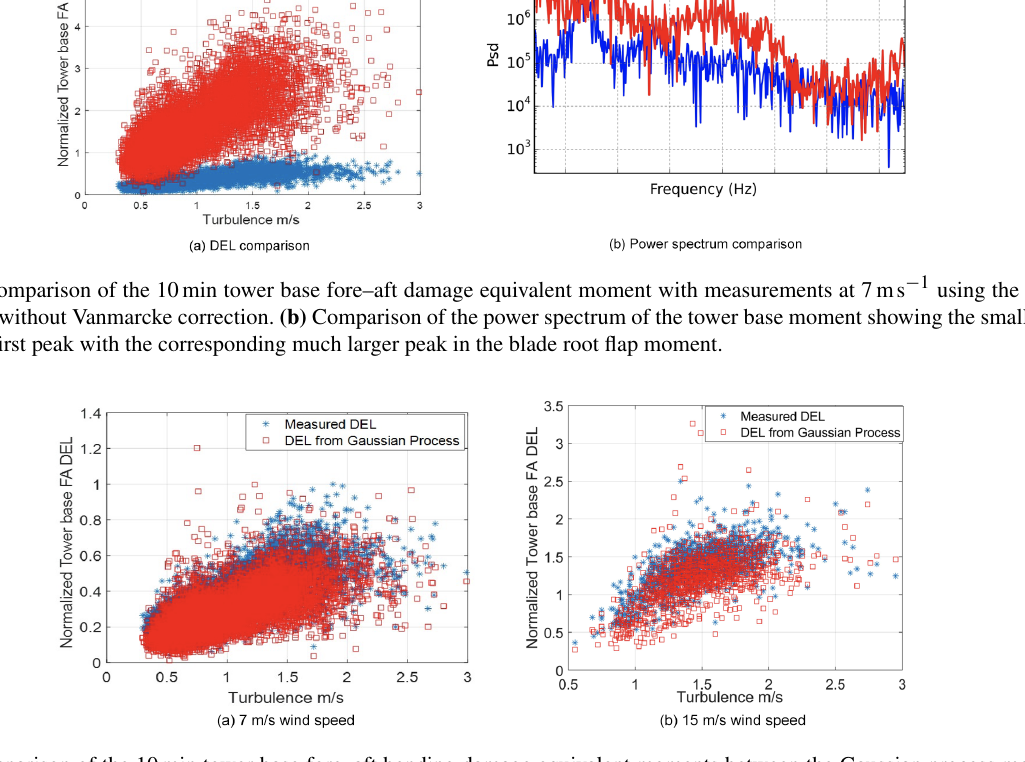
Figure 10. Comparison of the 10min tower base fore–aft bending damage equivalent moments between the Gaussian process method and measurement data on the C-08